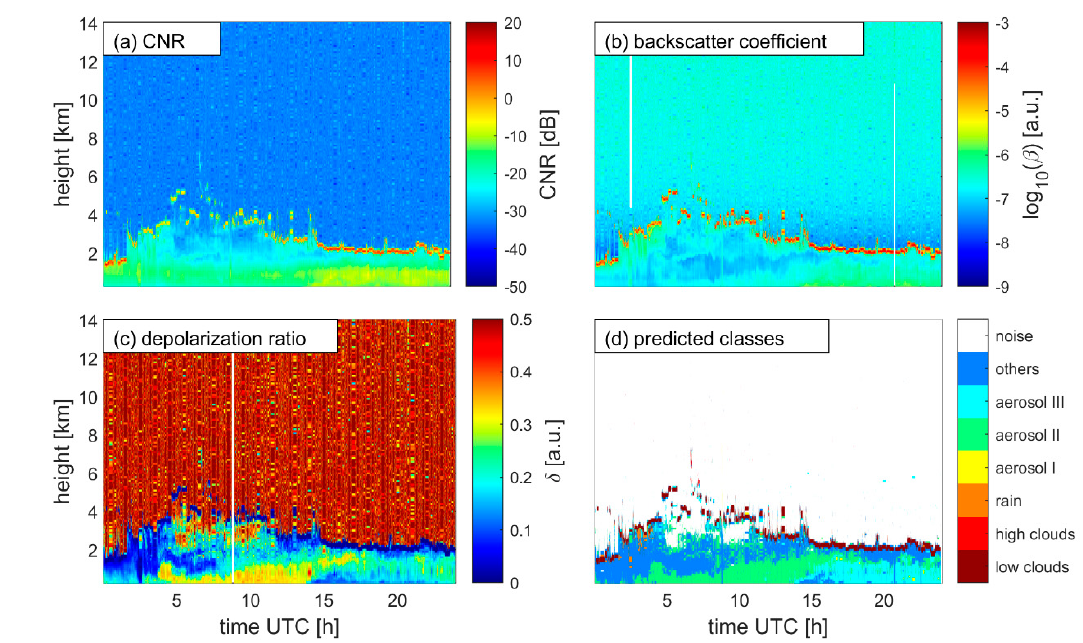
Figure 8. The lidar measurements on 31 July 2019, at Reykjavik ( a ) CNR, ( b ) backscatter coefficient, ( c ) depolarization ratio and the machine learning classification result ( d ) predicted classes.